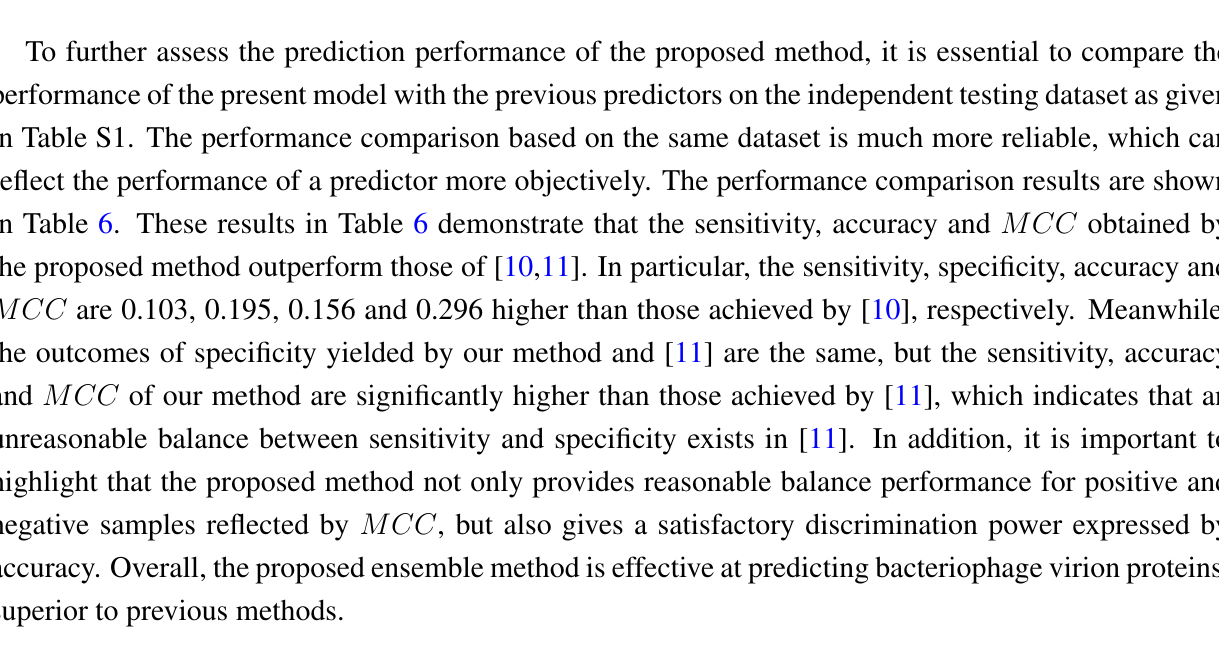
Table 6. Comparison of prediction performance with existing methods on the independent testing